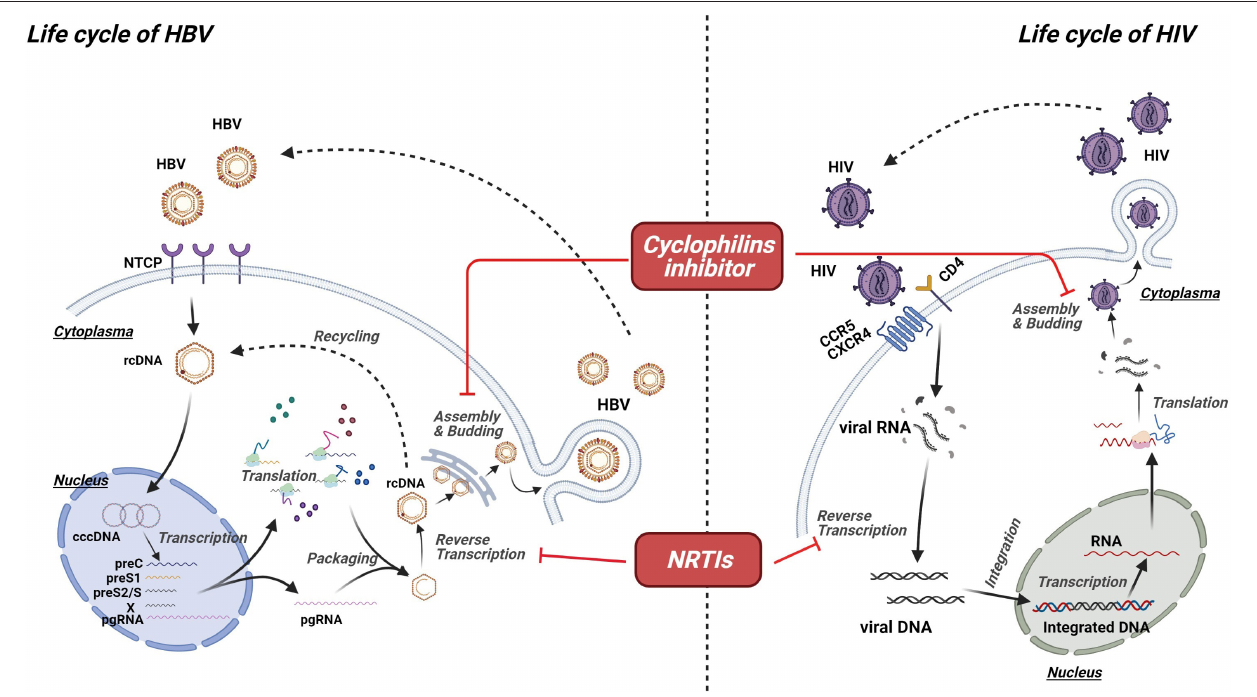
FIGURE 1 | Mechanism of virus-targeted agents. Though undergoing different life cycles, HBV and HIV share some similarities in their life cycles, which are important for the development of dual antiviral drugs for HBV and HIV. Activated nucleoside/nucleotide reverse transcriptase inhibitors (NRTIs) are capable of disturbing the functions of both HIV reverse transcriptase and HBV polymerase by competing with natural nucleotide substrates for joining into DNA chains, resulting in the chain termination and viral replication. Cyclophilin A (Cyp A) plays a crucial role in the replication of various viruses, including HBV and HIV. Thus, cyclophilins inhibitor could be a potential option for anti-HIV and anti-HBV